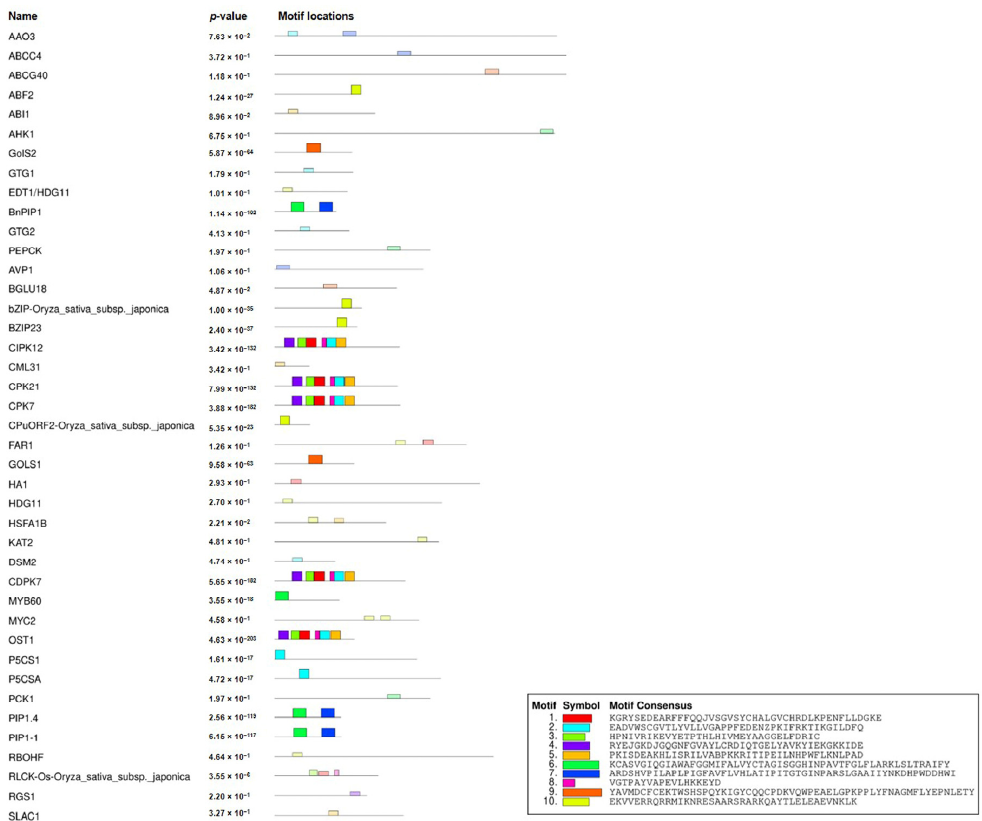
Figure 3. Presence of the conserved motifs in drought-related proteins. The consensus motif se- quences are shown at the bottom.